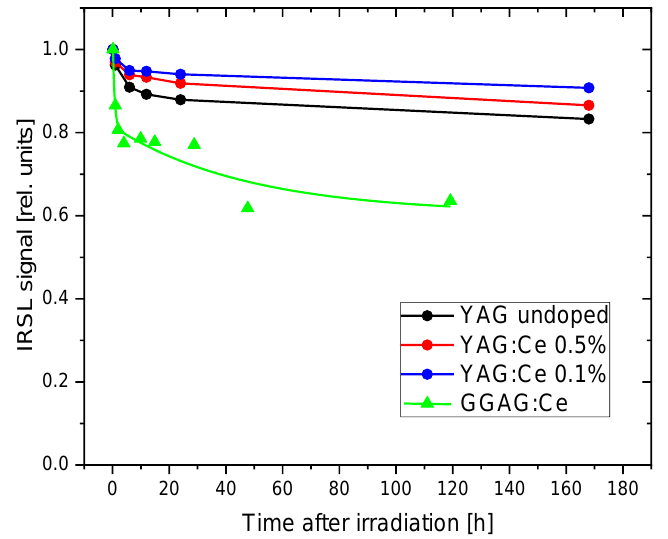
Figure 15. Fading of the IRSL signal during storage time after irradiation. The data are normalized to the first measurements, which were performed 10 min after the exposure. The lines are drawn only to guide the eye. Dose 1 Gy.